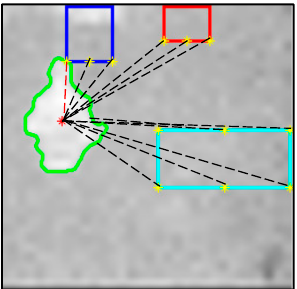
Figure 4. Depiction of the distance measurement between the person’s centroid and each object’s proximity points.